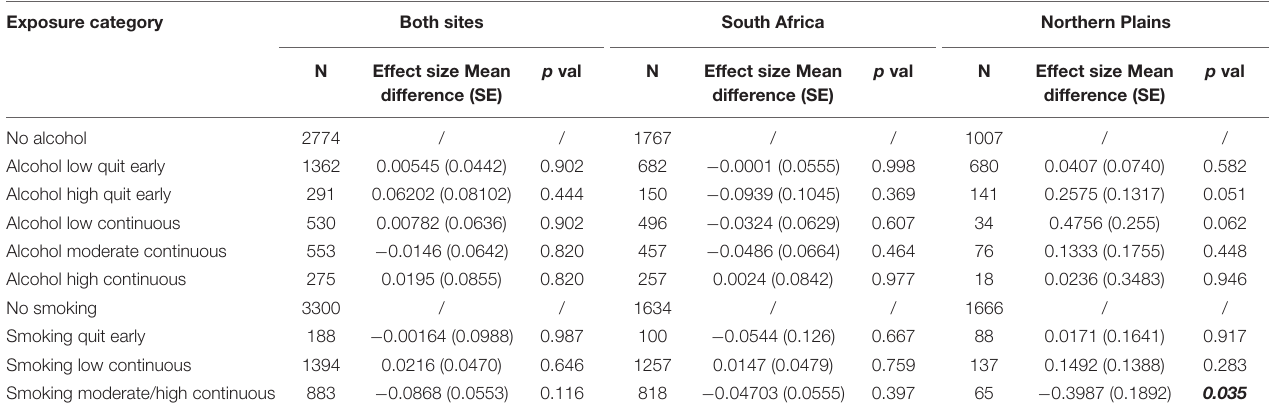
TABLE 8 | Linear regression results from alcohol and smoking exposure predicting HR − SD in 2F.